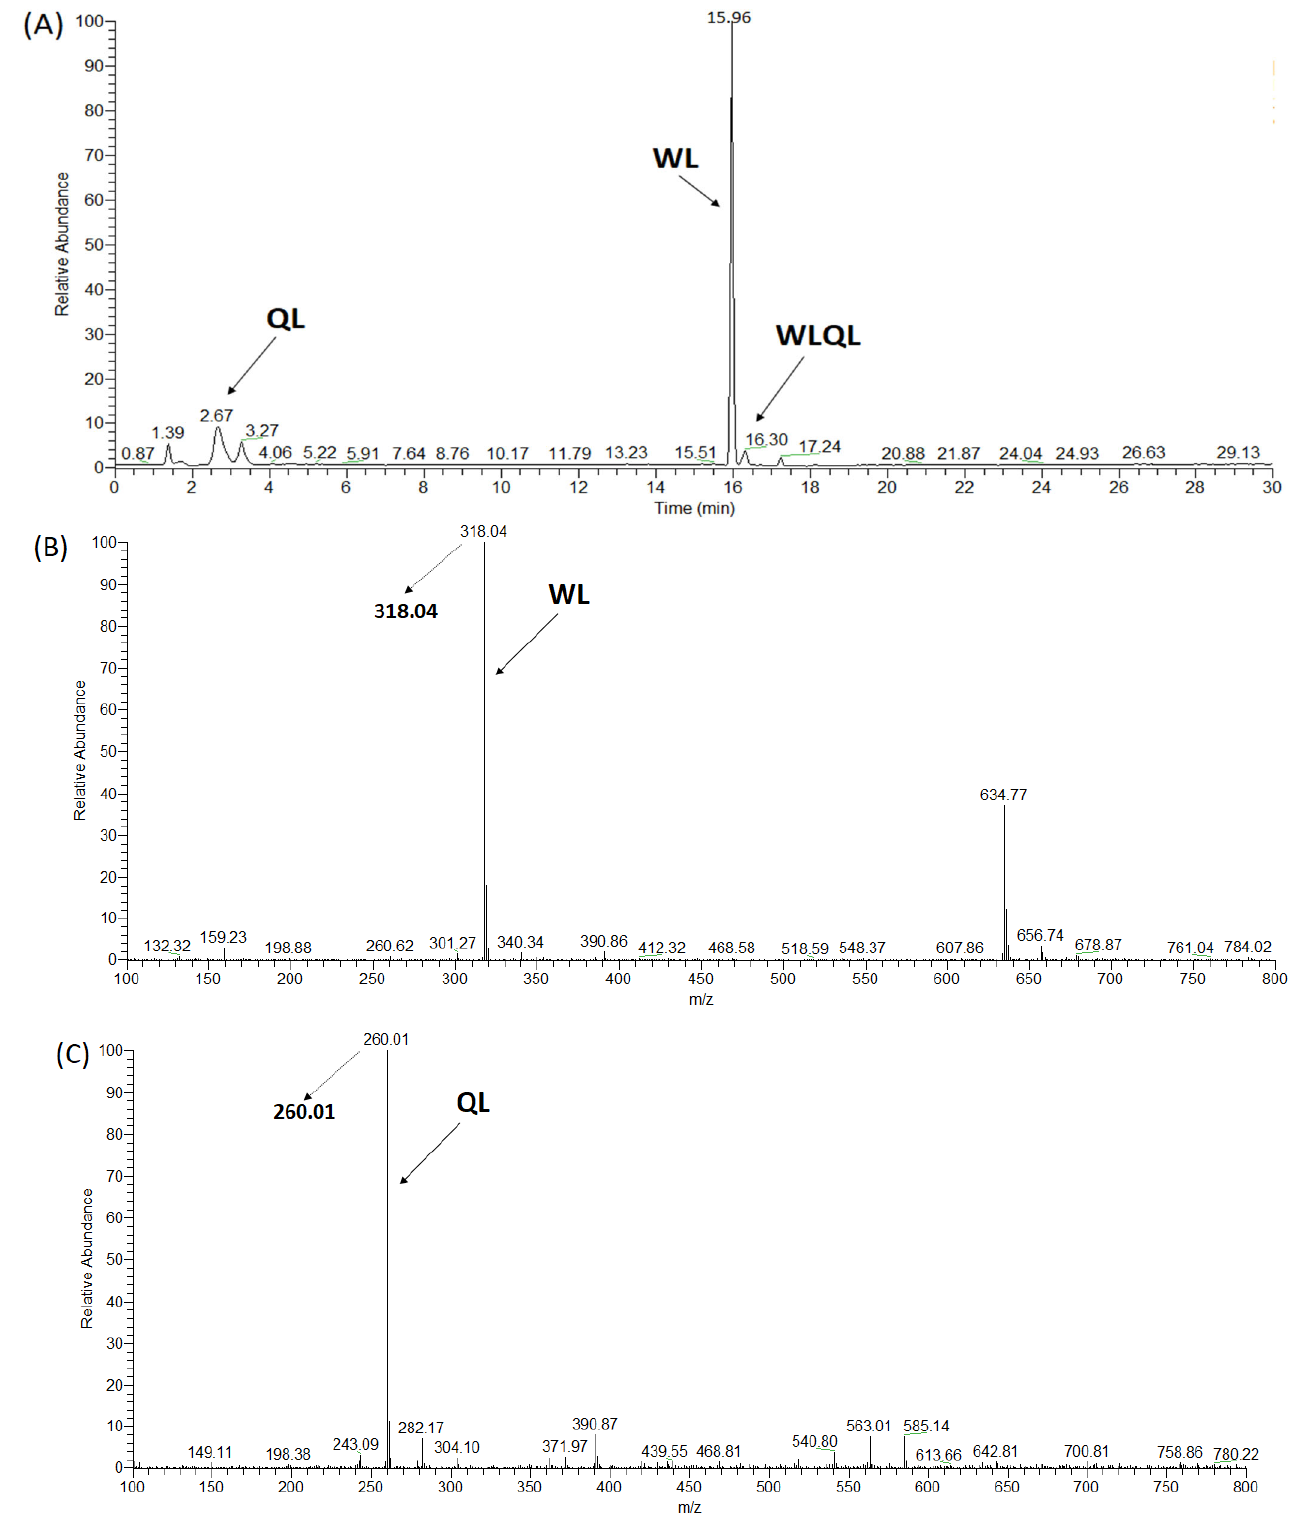
Figure 3. Liquid chromatography–mass spectrometry (LC-MS) profile of ( A ) WLQL full scan (m/z 559.30), ( B ) WL fragment (m/z 318.02); ( C ) QL fragment (m/z 259.99) derived from WLQL pre ‐ incubated with ACE for 3 h at 37 °C.